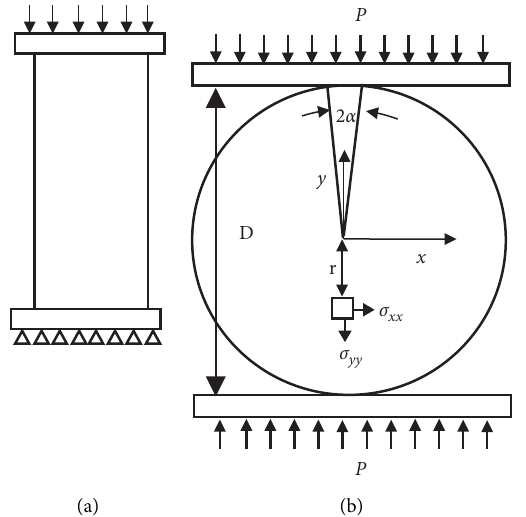
Figure 1: Geometrical model for UCS and BTS test. (a) Geometrical model for UCS test. (b) Geometrical model of BTS